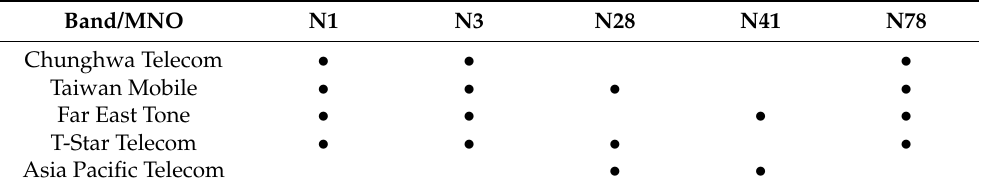
Table 3. List of frequency bands available in Taiwan by